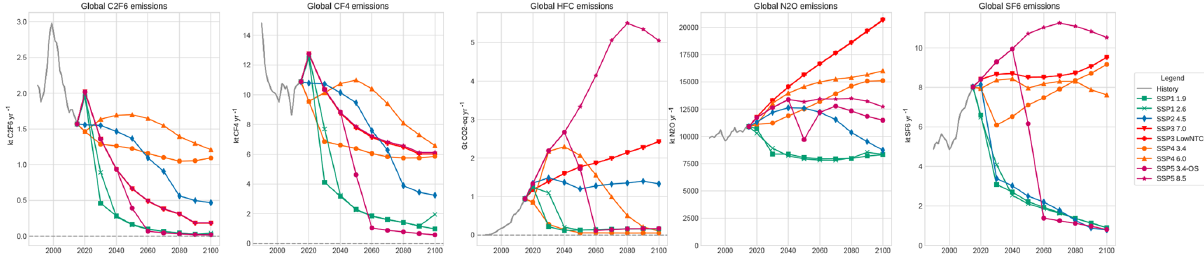
Figure E1. Emissions trajectories for all GHGs and all scenarios analyzed in this study.